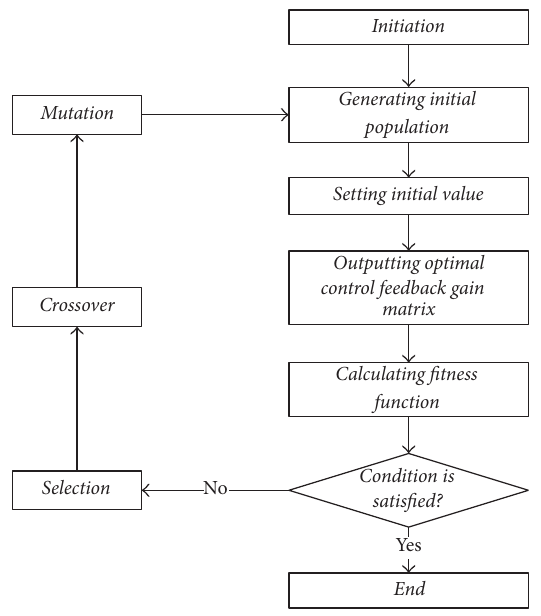
Figure 3: Flow chart for optimizing LQG controller based on